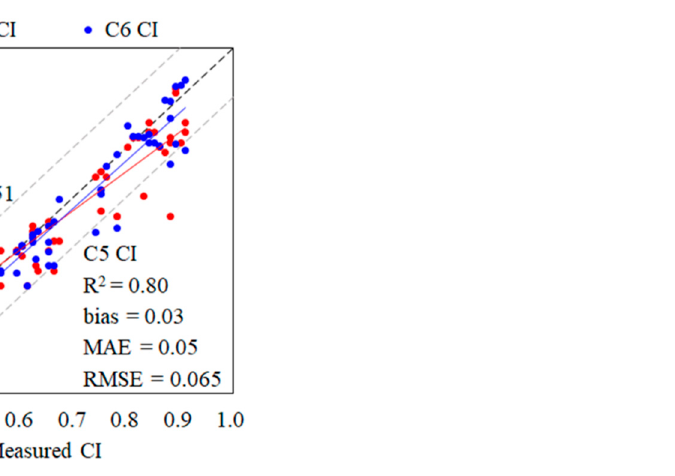
Figure 6. Comparison between the monthly C5 and C6 CI retrievals and field measurements. Details of the field CI data are shown in Table 1. The red and blue dots indicate the C5 and C6 CIs, respectively. Solid regression lines represent the linear fits of the field ‐ measured CIs with the MODIS CIs, which shows a higher accuracy acquired by using the updated version of upstream MODIS BRDF/albedo products.